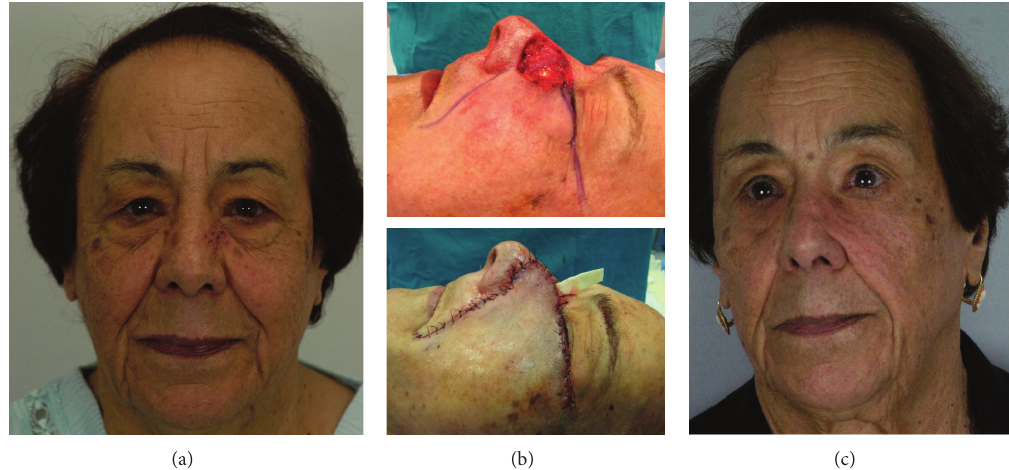
Figure 3: Patient no. 12 showed in Table 1. (a) Basal cell carcinoma of the left nasal sidewall and infraorbital unit; (b) (intraoperative view) 3.2 × 3.8 cm defect after tumor resection. Advancement cheek flap designed with inferior incision outlined in the nasofacial sulcus and melolabial crease and superior incision placed in a subciliar line (up). Flap inset (down). (c) Final result 24 months after operation.